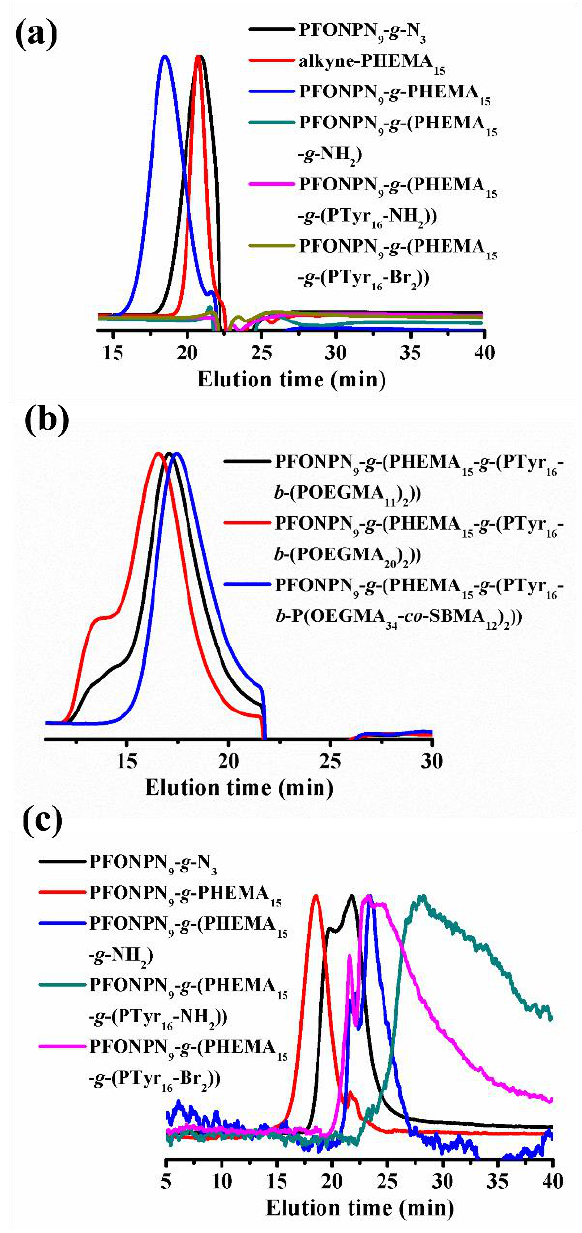
Figure 1. SEC elution traces (dRI signals) of macroinitiator I 1 -I 6 ( a ) and amphiphilic bottlebrush copolymers P 1 , P 3 , and P 5 ( b ), as well as SEC elution traces (UV signals) of macroinitiator I 1 , I 3 -I 6 ( c ). Moreover, the ratio of the integrated intensity of peak a or peak b assigned to the methylene protons adjacent to 1,2,3-1 H -triazole to that of peak a’ ascribed to the methylene protons adjacent to azide of PFONPN- g -PHEMA (Supplementary Materials, Figure S2b) was calculated to be 1/1.51, indicating 40% grafting of